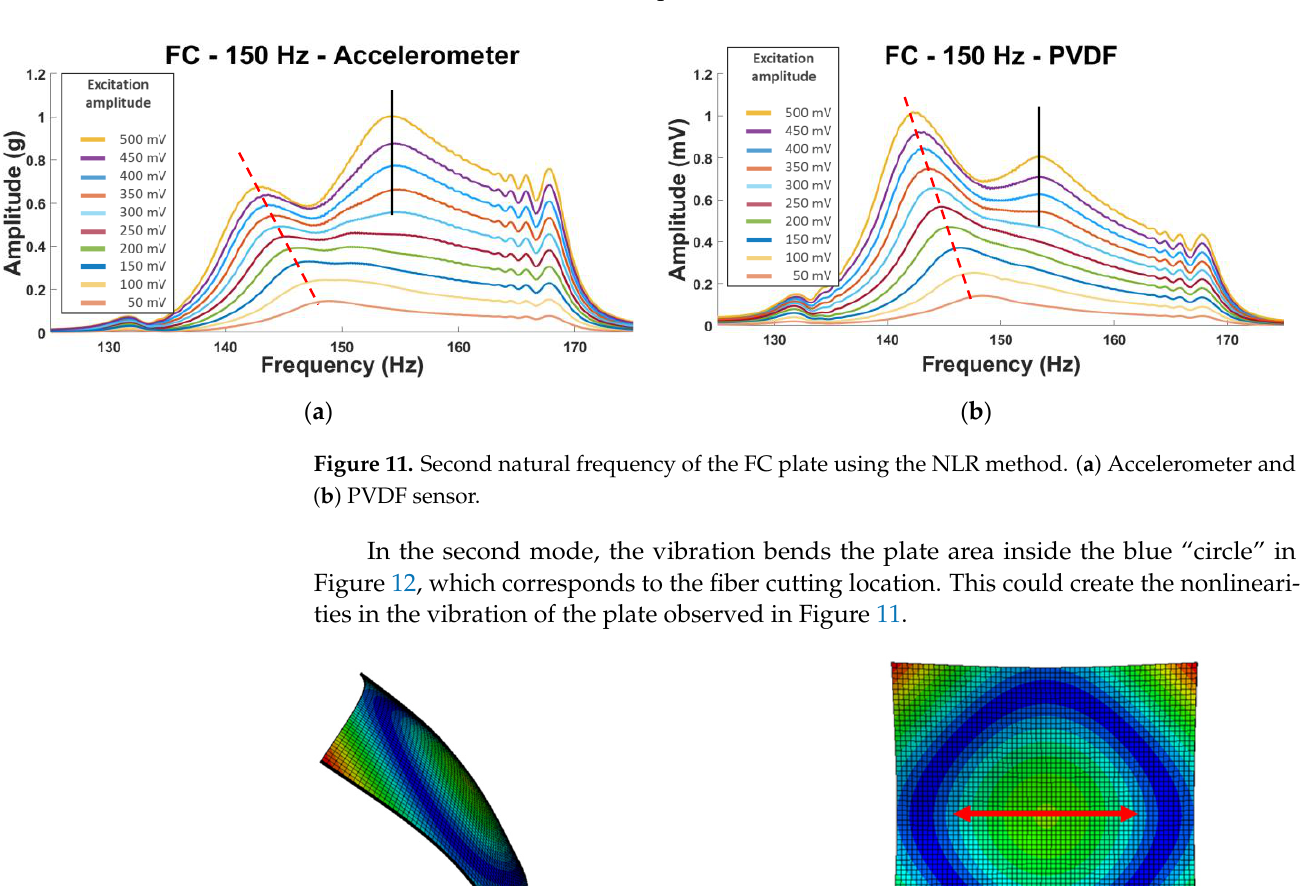
10 of 21 Figure 10. Frequency shift vs amplitude of excitation: second, fourth, and fifth natural frequencies.